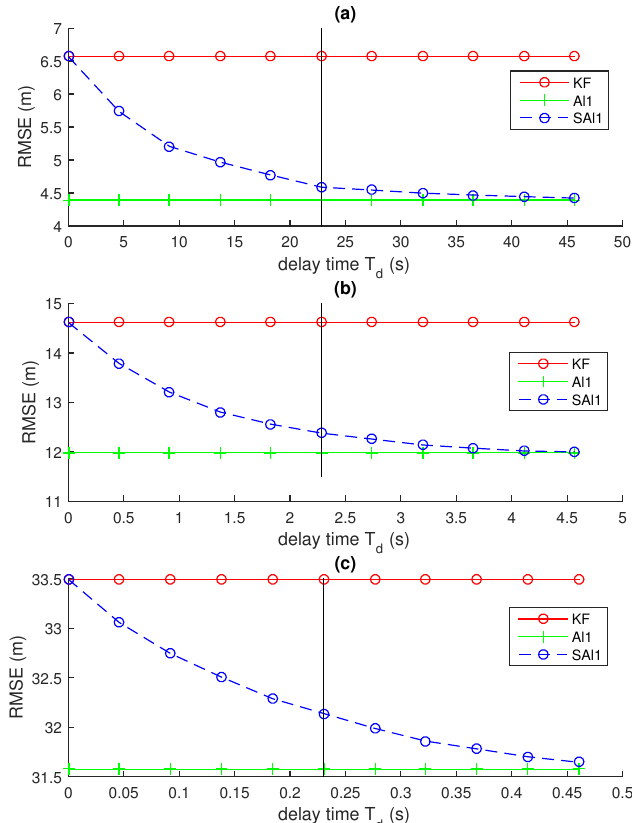
Figure 4. Performance of selective out-of-sequence filters as a function of the cut-off time T stale . The vertical line represents the theoretical cut-off T d computed using (8) with a k min / k value of 0.6. ( a ) σ Q = 0.5, σ R = 50, ∆ T D = 50; ( b ) σ Q = 5, σ R = 50, ∆ T D = 4; ( c ) σ Q = 50, σ R = 50, ∆ T D = 0.75. In all runs, f = 1, h = 1, ∆ T P =